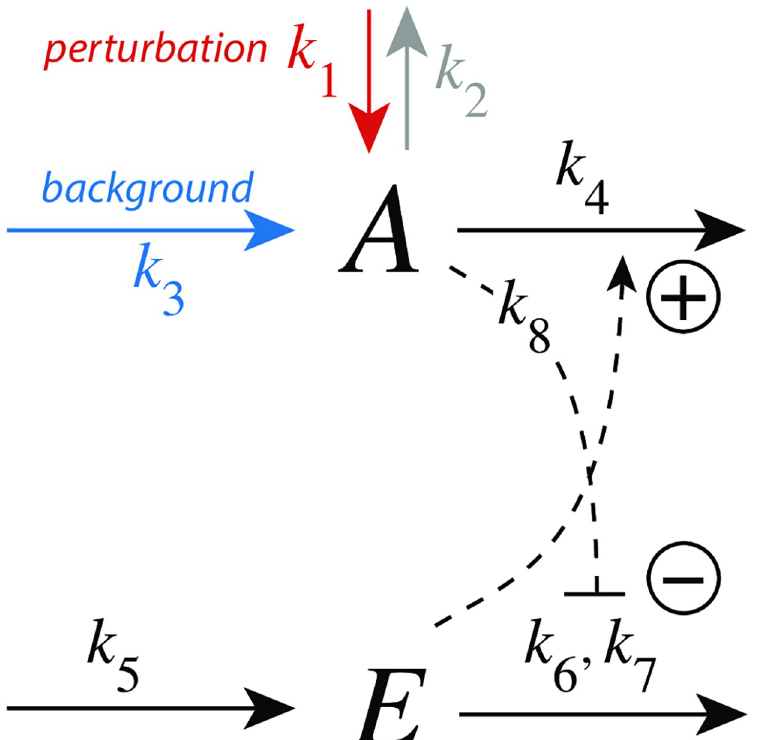
Fig 5. Outflow controller motif m7 with integral control implemented as a zero-order Michaelis-Menten (MM) type degradation of E . The perturbation k 1 changes step-wise (1.0 ! 5.0), while k 3 is a constant background. Rate constant k 4 relates to the outflow of A , and k 8 is an inhibition constant. k 6 and k 7 are MM parameters analogous to V max and K M , respectively. In the calculations the grayed-out rate constant k 2 is, for the sake of simplicity, set to zero.